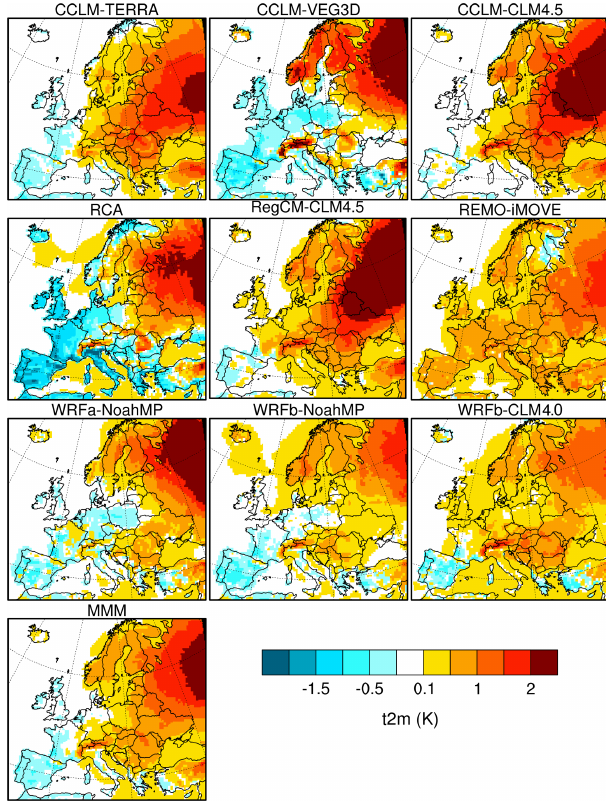
Figure 1. Seasonally averaged 2m temperature (FOREST minus GRASS) for winter